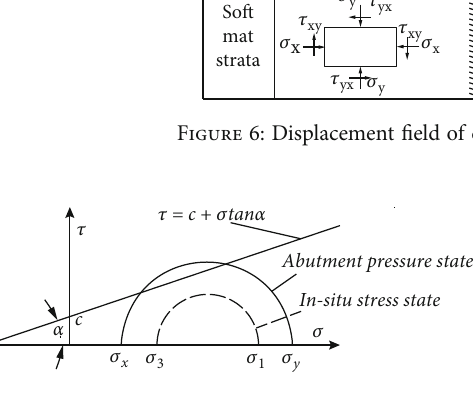
Figure 7: Analysis of Mohr-Coulomb strength curve of rock